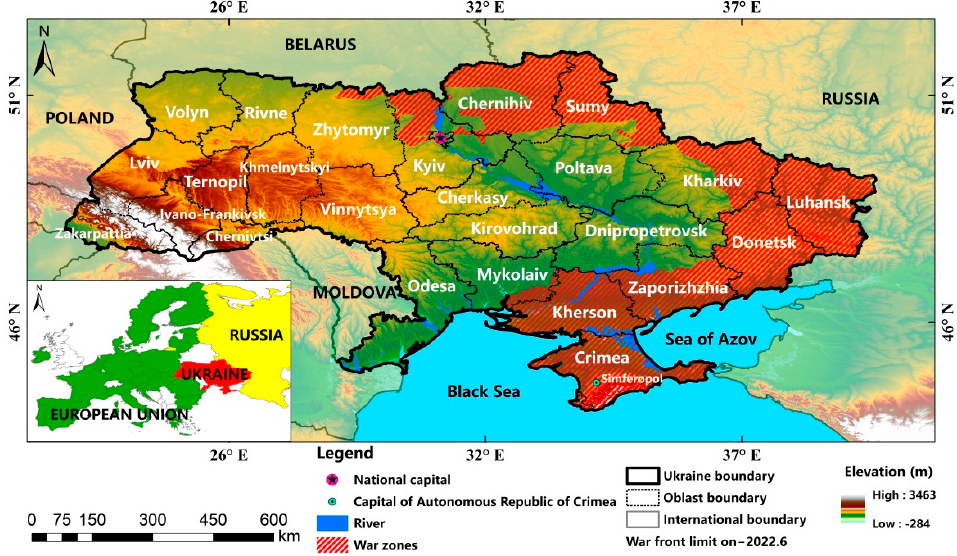
Figure 1. Study region map of Ukraine with respect to war zones and elevation.